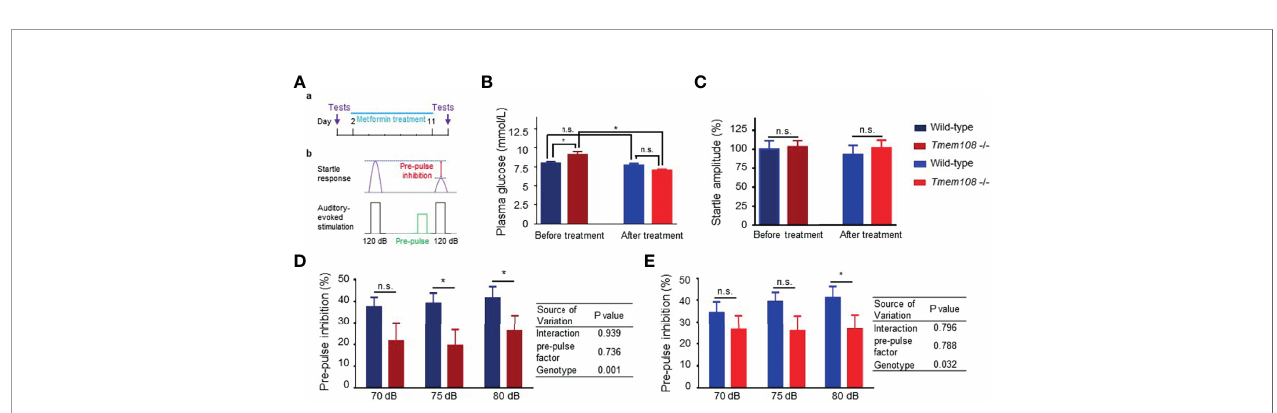
FIGURE 6 | Metformin enhanced startle responses of Tmem108 mutant mice. (A) Diagram of pre-pulse inhibition (PPI) test. The response to auditory-evoked startle stimulus (120 dB) was conducted. PPI test was introduced again after ten-day treatment of metformin. (B) Baseline of plasma glucose level was ameliorated after metformin treatment, wild-type as the control. (C) Baseline startles responses were similar between the two genotypes of mice. (D, E) . PPI was measured in both types of mice before or after metformin treatment. Compared with the control mice, reduced PPI in Tmem108 mutant mice was found at pre-pulse (75 dB and 80 dB) before metformin treatment (D) , and PPI decrease in Tmem108 mutant mice was found only at pre-pulse 80 dB after metformin treatment (E) . (n = 8 per group, male mice; data are represented as means ± SEM; unpaired t -test, n.s., not signi fi cant, *p < 0.05).